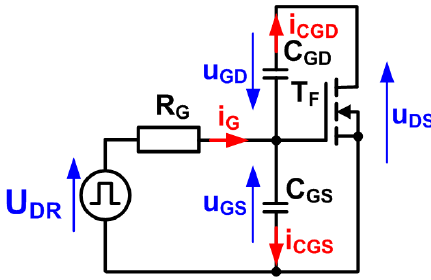
Figure 8. A gate circuit of the MOSFET transistor.